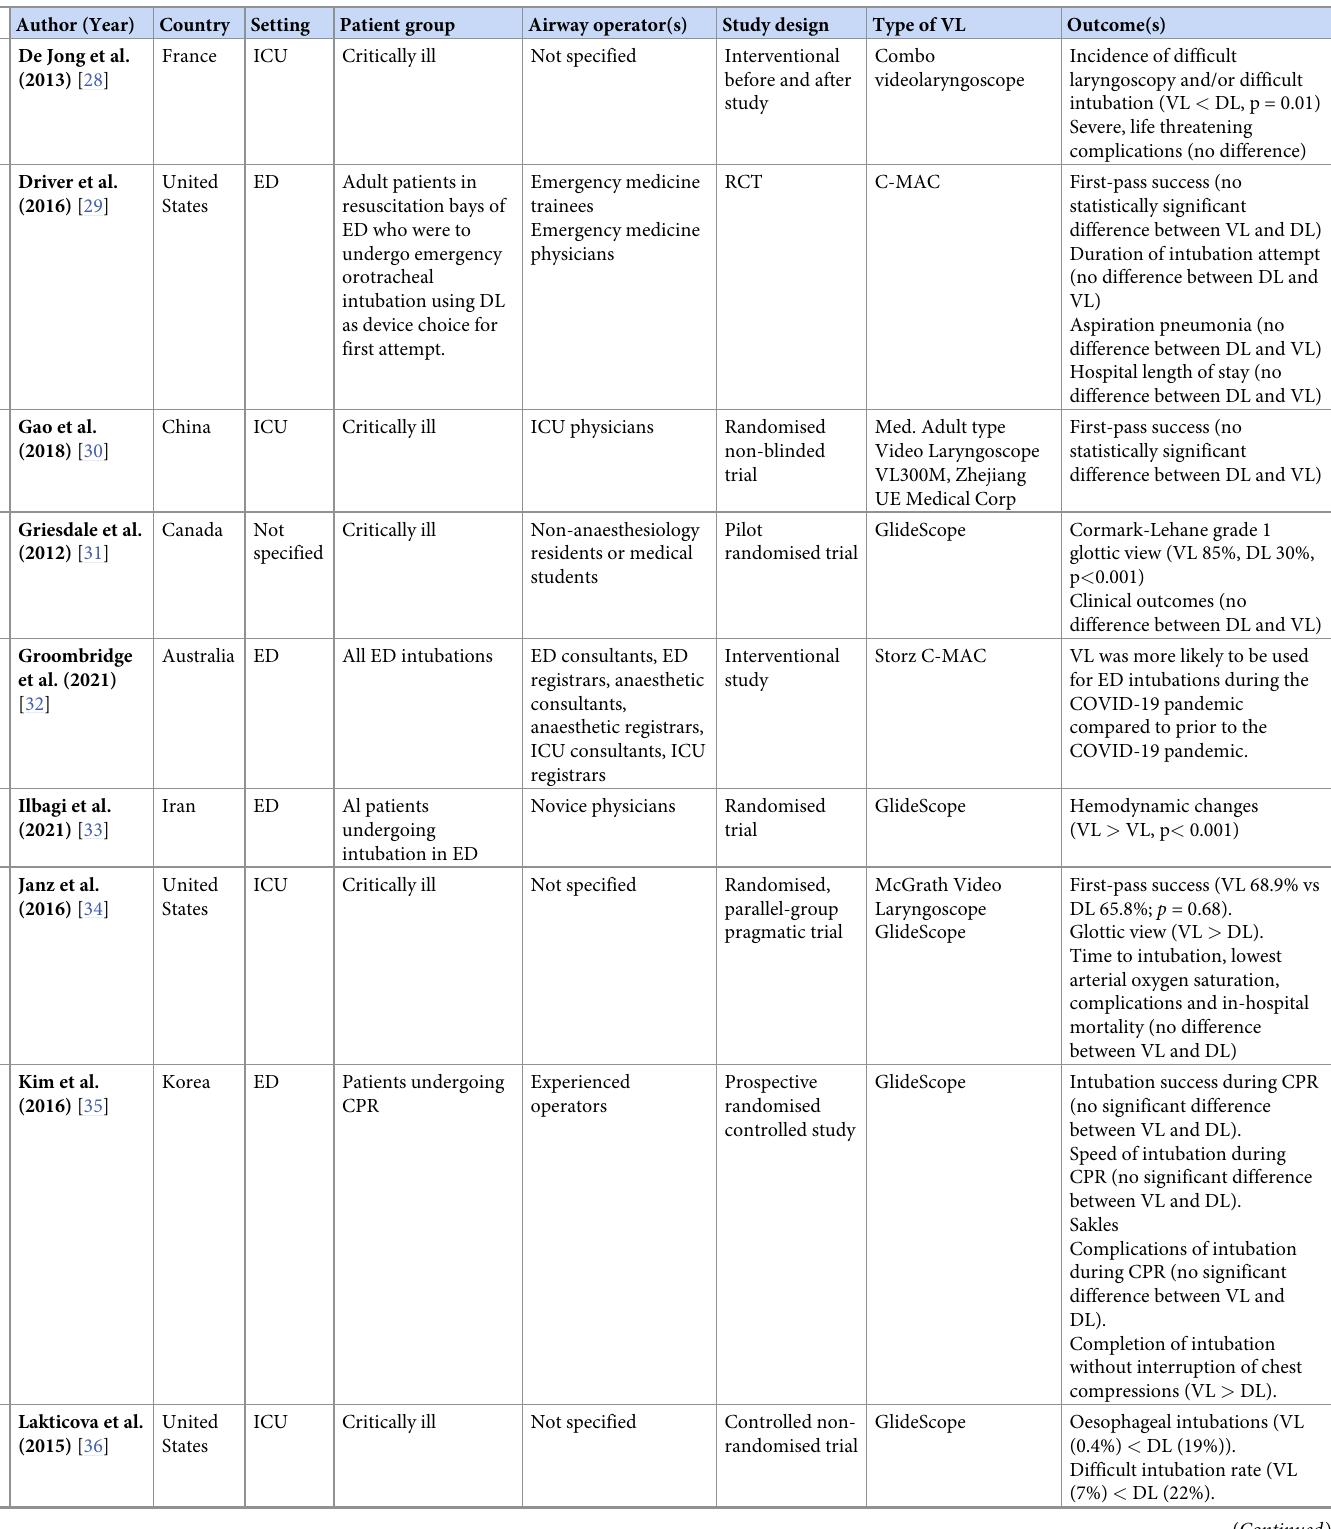
Table 2. Interventional studies on the use of VL outside the OR. Author (Year) Country